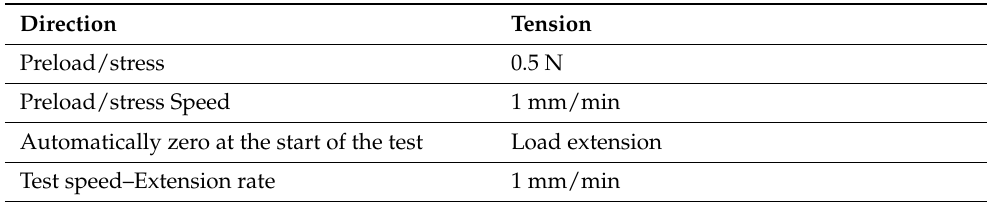
Table 2. Testing machine